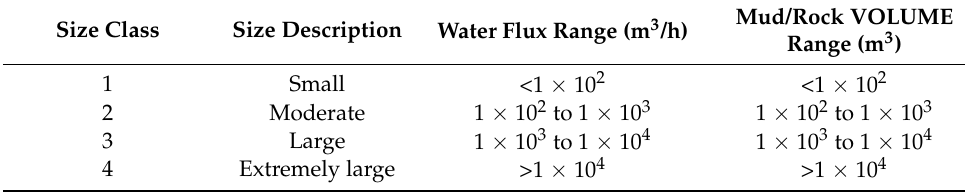
Table 2. Updated size classification for water and mud/rock inrush in Karst tunnels.